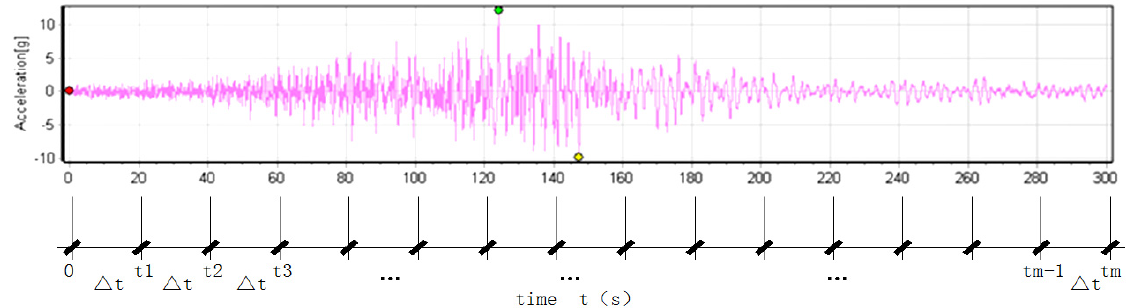
Figure 3. Schematic diagram of seismic wave splitting.